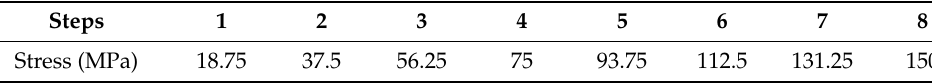
Table 1. Stress in each step of the loading procedure.